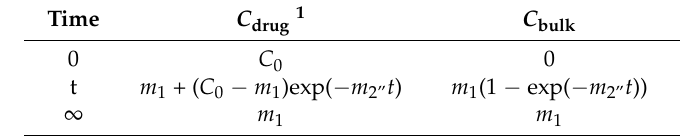
Table 2. Concentrations inside ( C drug ) and outside ( C bulk ) the tablet at different times. Time C drug 1 C bulk 0 C 0